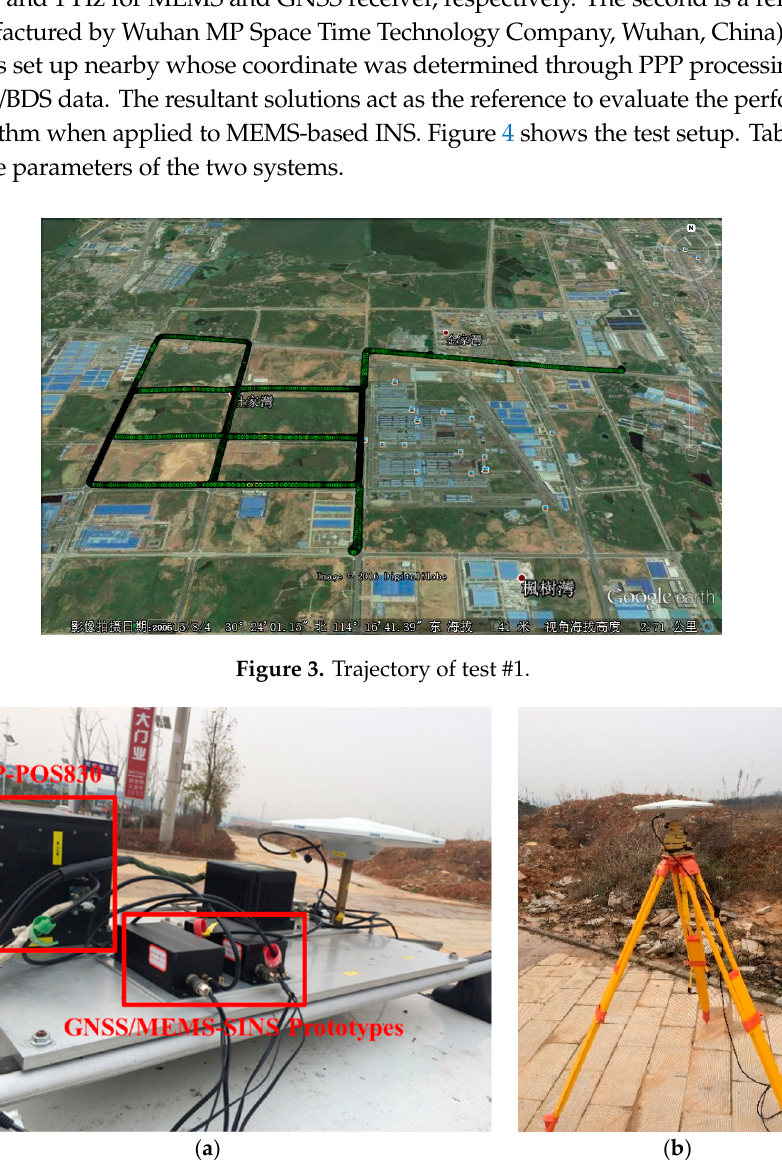
Table 2. POS830 reference system performance parameters.